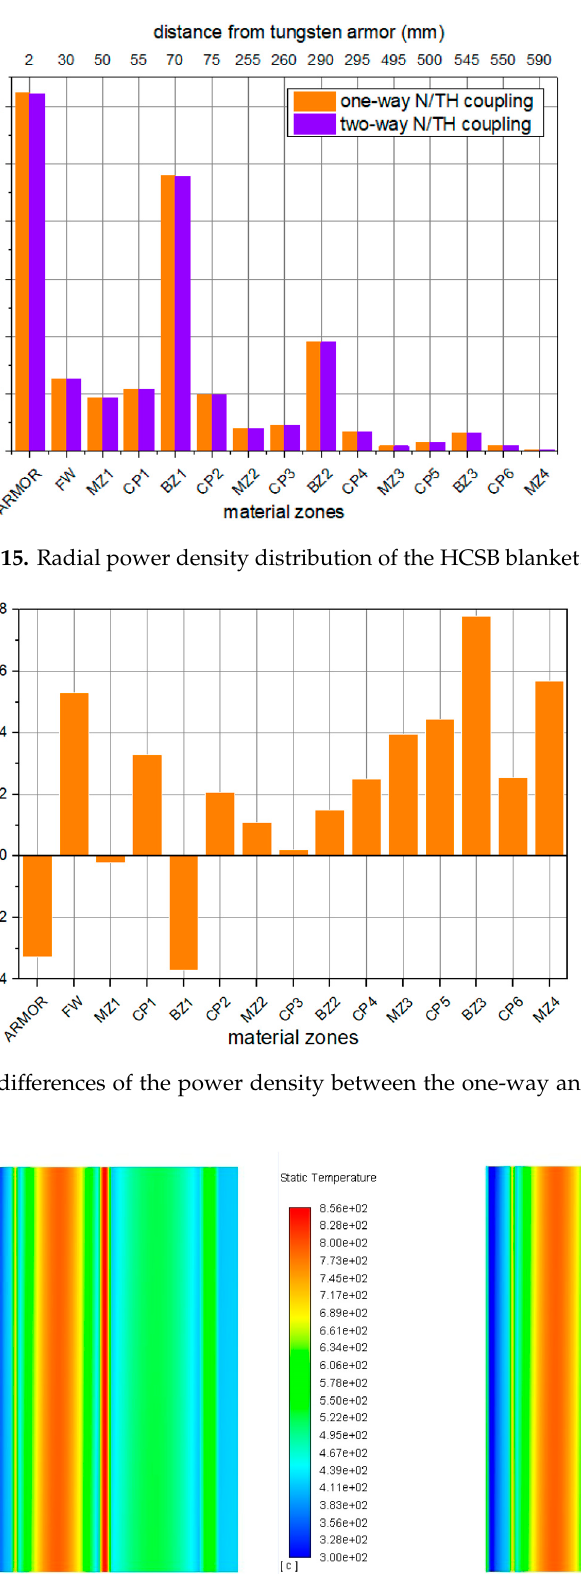
Figure 18. Comparison of the temperature distribution along the radial direction. 3.2. The N/TH Coupling Calculation of WCCB Blanket 3.2.1. The Sensitivity Analyses of Temperature Different from helium, light-water, which possesses the excellent neutron-moderating capability, will affect the neutron spectrum and generate more thermal neutrons in blanket. Considering the tritium production cross sections of the lithium are large in the low-energy ranges, the changes of density and temperature of water will obviously influence the TBR. To investigate and understand the temperature effect in different materials in the WCCB, the temperature sensitivity analyses of tritium breeder, neutron multiplier, and coolant are carried out. The temperatures of all materials are set to 20 °C firstly, and the density of water depends on its temperature. Because the saturated temperature of water is 345 °C with the pressure to be 15.5 MPa, only cases with 20 °C and 327 °C are calculated. The importance of the S ( α , β ) table was proven in the previous section, so the cases without considering S ( α , β ) are not calculated in this section. Table 11 lists the calculation results. The variation tendencies of the neutron multiplier and the tritium breeder are similar to the HCSB. When the neutron multiplier temperature increases, the TBR increases, but the nuclear heat deposition decreases. Because the volume fraction of the neutron multiplier is small in the WCCB, the temperature effect has been diminished. Between 20 °C and 327 °C , the TBR and the nuclear heat deposition increase with the increase of the tritium breeder